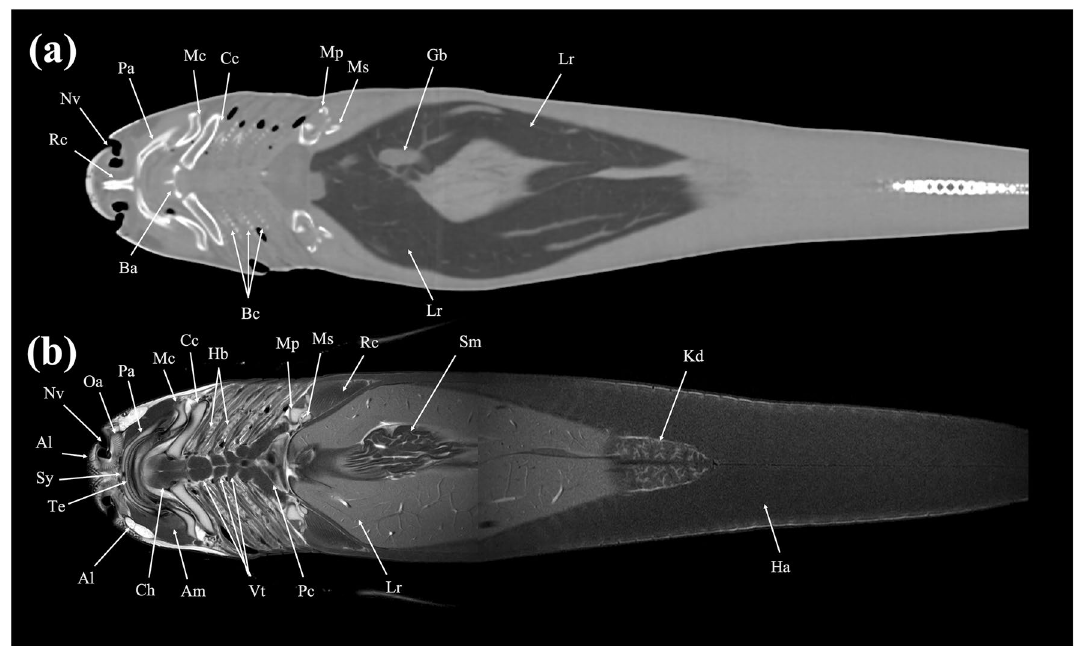
Figure 22. Dorsal ( a ) CT and ( b ) MR images of a banded houndshark ( Triakis scyllium ) at level 22 of Fig. 25. Al Ampullae of Lorenzini, Am Adductor mandibularis, Ba Basihyal cartilage, Bc Branchial cartilage, Cc Ceratohyal cartilage, Ch Coracohyoideus, Ha Hypaxial, Hb Hypobranchial, Gb Gall bladder, Kd Kidney, Lr Liver, Mc Meckel’s cartilage, Ms Mesopterygium, Mp Metapterygium, Nv Nasal cavity, Oa Olfactory lamellae, Pa Palatoquadrate, Pc Pericardial cavity, Vt Ventral constrictors, Rc Rostral cartilage, Te Teeth, Sm Stomach, Sy Symphysis.